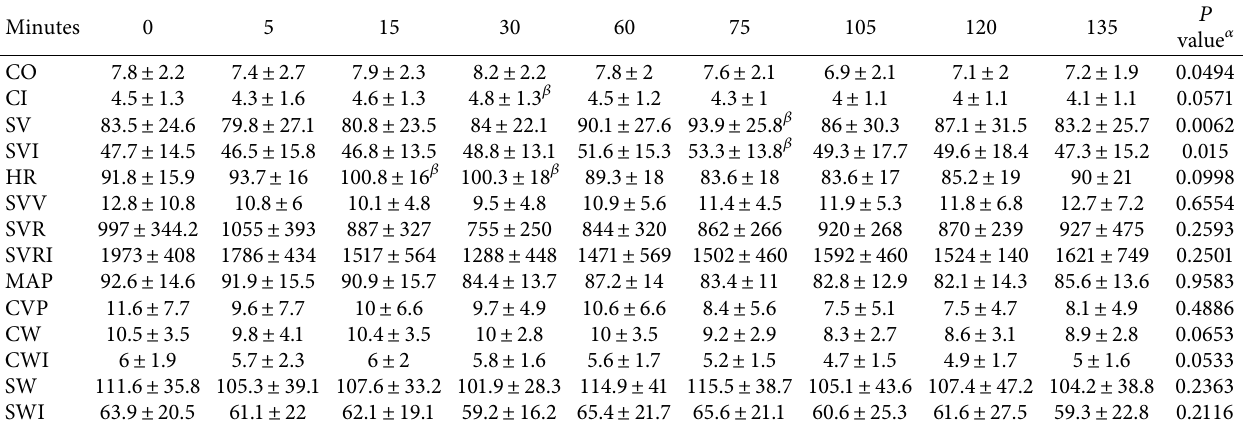
Table 3: Hemodynamic parameters (mean, standard